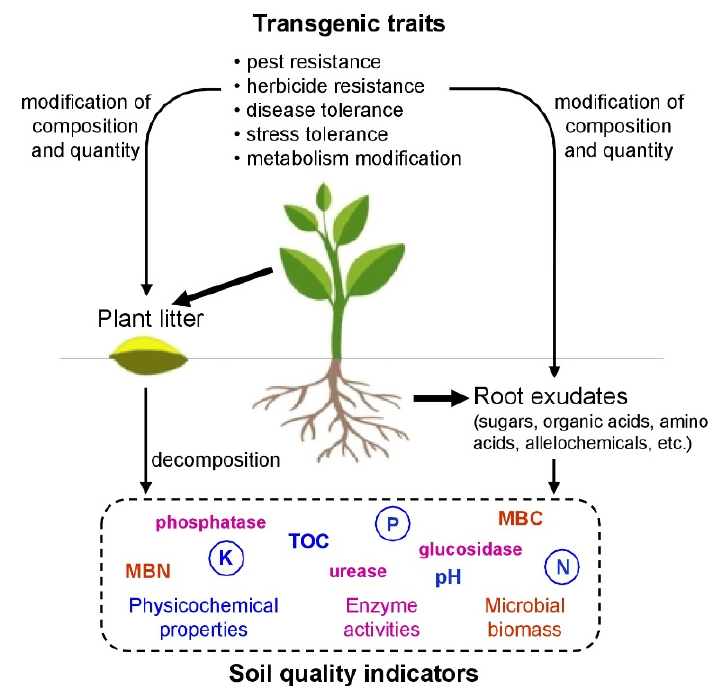
Figure 1. Potential impact of transgenic plants on soil quality indicators.